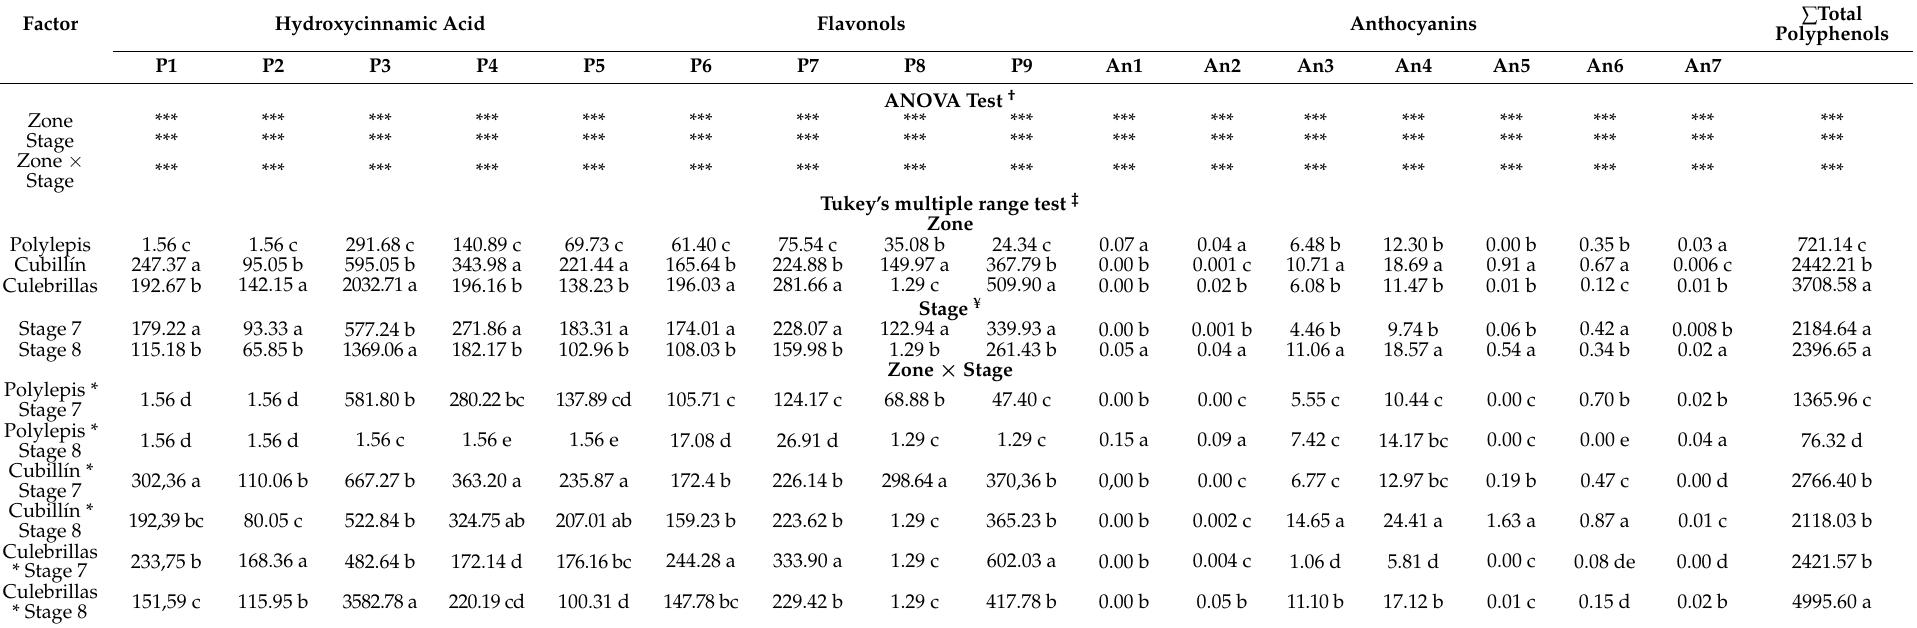
Table 7. Phenolic compounds quantified in Mortiño berries as affected by sampling zone and stage of fruit development (mg 100 g − 1